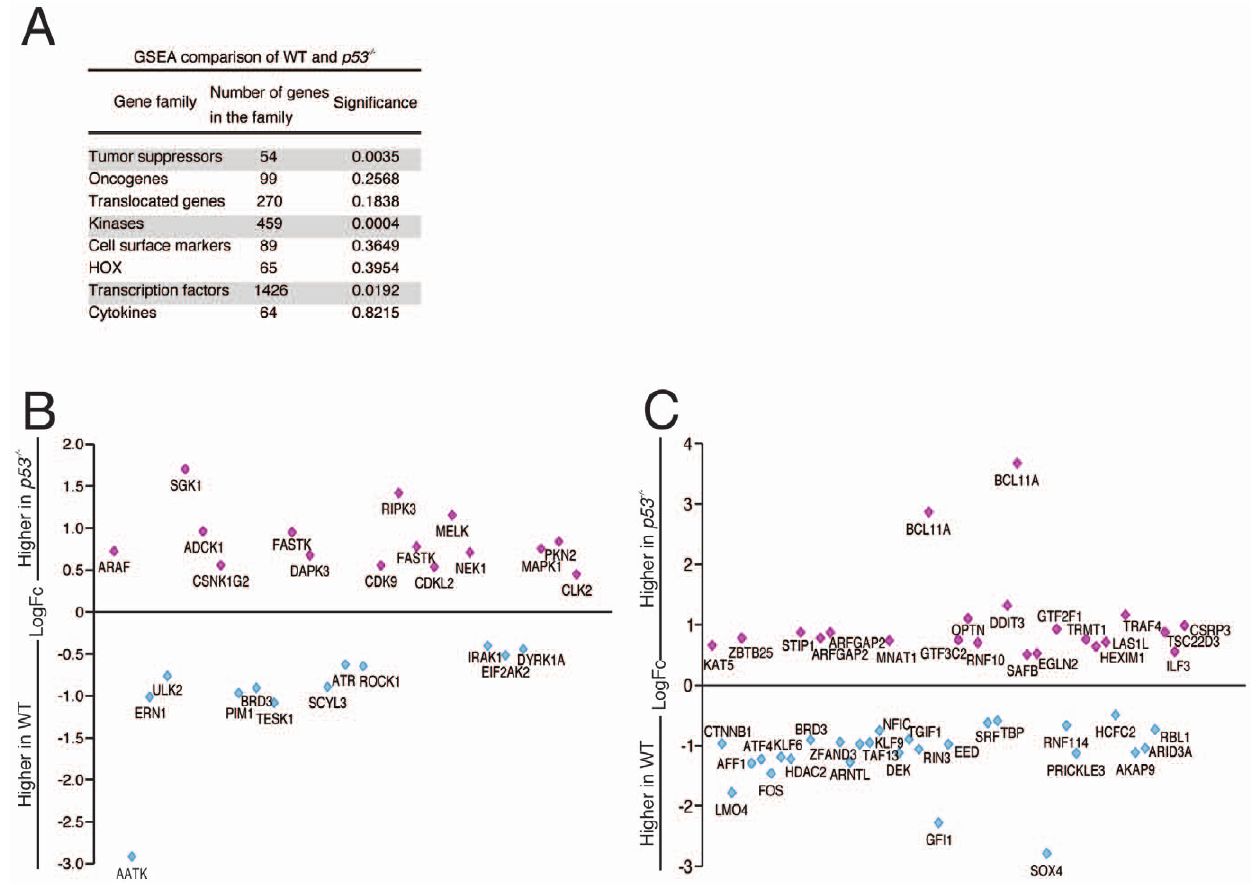
Figure 3. Gene set enrichment analysis of WT and p53 2 / 2 expression array data. (A) Gene Set Enrichment Analysis (GSEA) of the WT and p53 2 / 2 gene lists at the various time points. GSEA was conducted using all genes that were considered expressed in the array, based on their detection p-value. A p-value of less than 0.05 was considered significant. (B) (C) Each diamond represents an individual probe for significantly differentially expressed kinases (B) or transcription factors (C) in WT and p53 2 / 2 FDM cells cultured in IL-3.